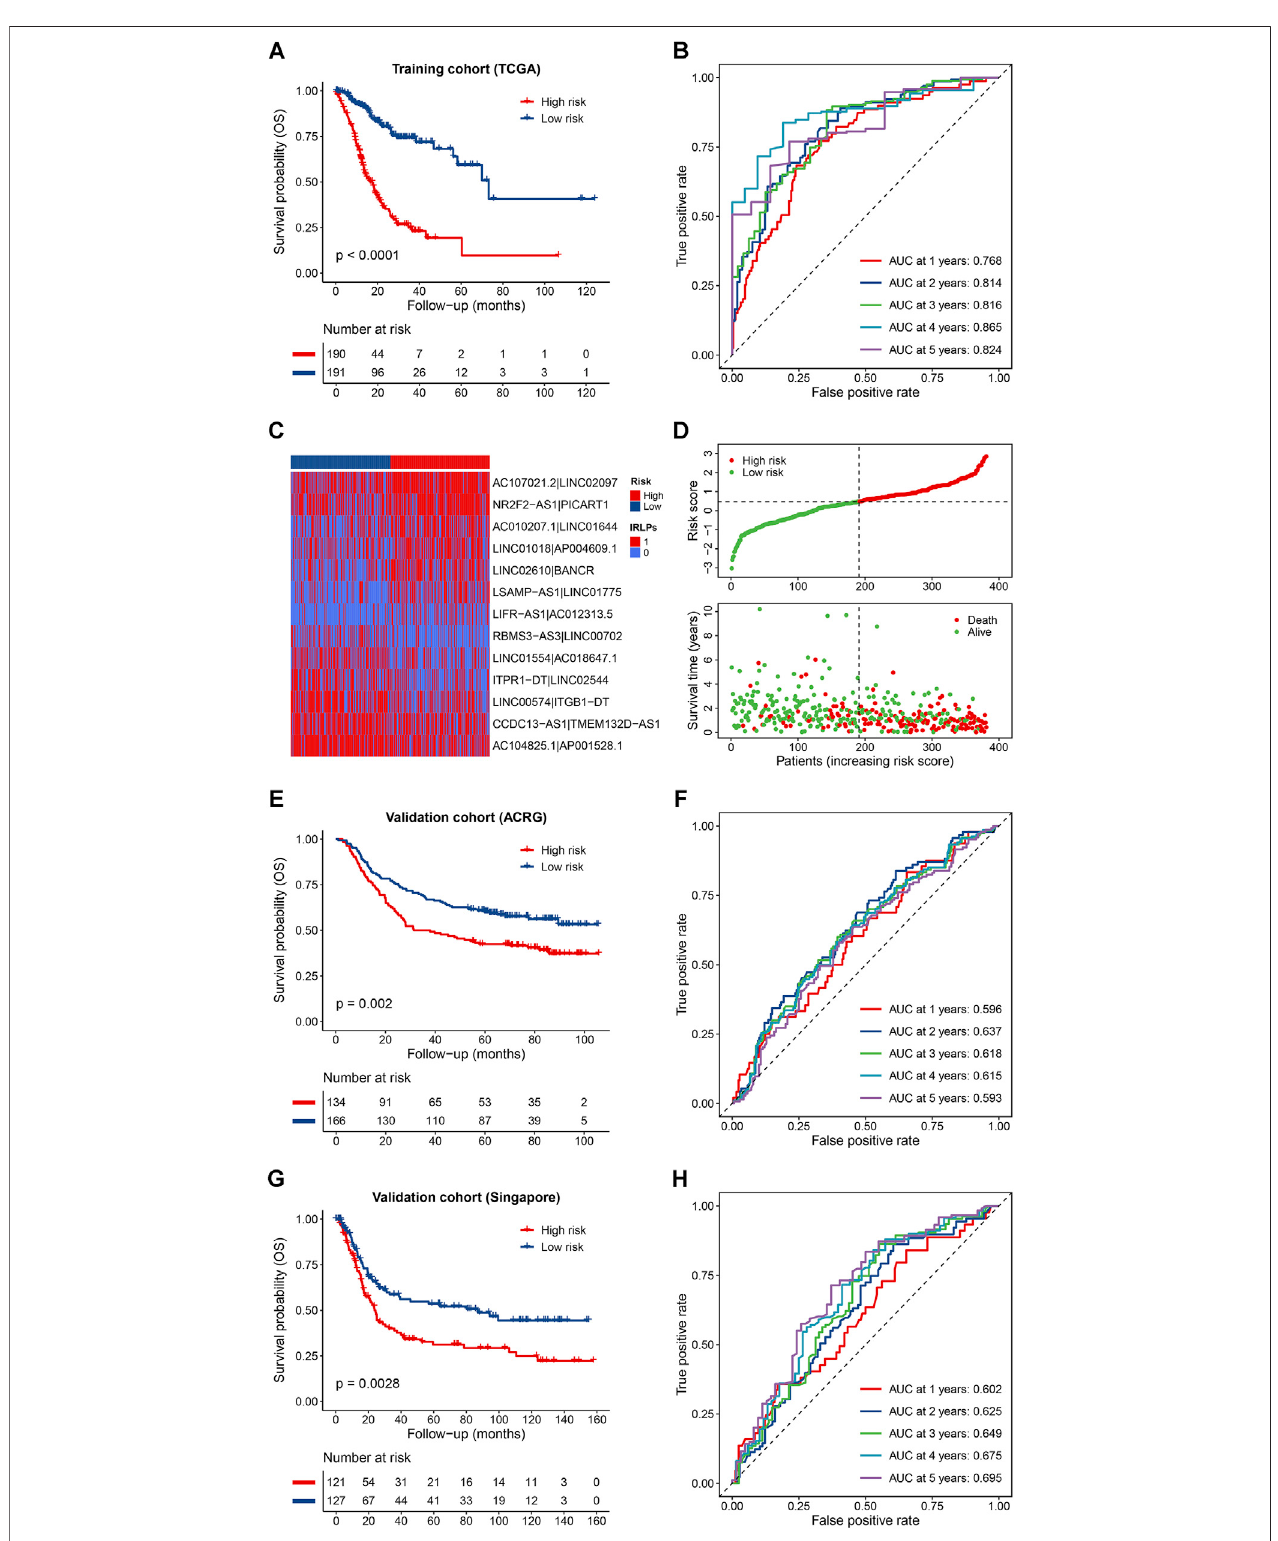
FIGURE 2 | Predictive effects of the prognostic signature. (A,B) Kaplan-Meier curves and time-dependent receiver operator characteristic (ROC) curves of the signature for predicting the overall survival (OS) of patients in the TCGA cohort; (C,D) Heatmap of the immune-related lncRNA pairs (IRLPs) in the high- and low-risk groups,rankoftheriskscore,anddistribution ofthesurvivalstatus; (E,F) Kaplan-Meiercurvesandtime-dependent ROCcurvesofthesignatureforpredictingtheOSof patientsintheAsianCancerResearchGroup(ACRG) cohort; (G,H) Kaplan-Meiercurvesandtime-dependent ROCcurvesofthesignatureforpredictingtheOSof patients in the Singapore cohort.